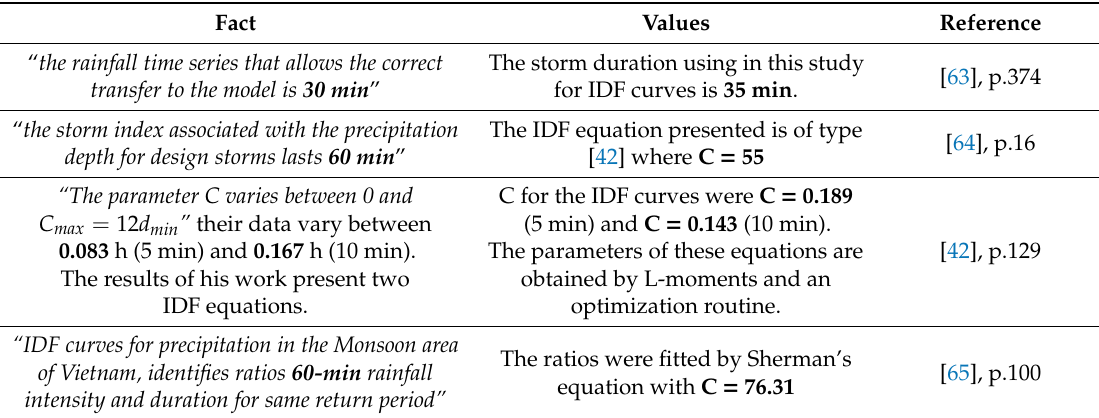
Table 6. Some evidence that authors calculate parameter C by some traditional procedure; but